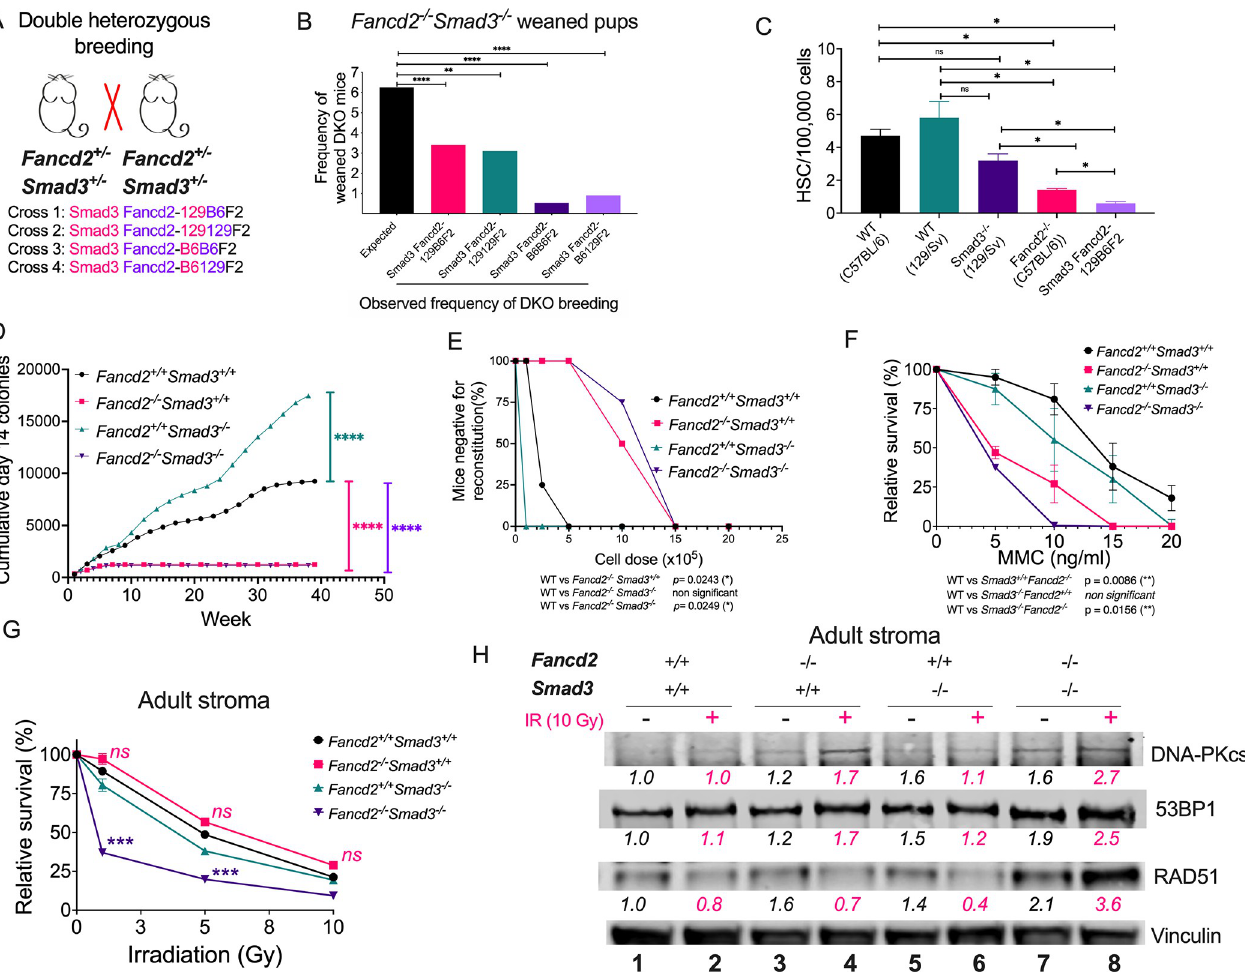
Fig 2. Smad3 loss is synthetic lethal with Fancd2 loss and surviving DKO mice do not have improved adult hematopoiesis. (A) Two different Smad3 +/- and Fancd2 +/- mouse strains on two different genetic backgrounds (129/Sv and C57BL/6) were bred to obtain 4 strains of Smad3 -/- Fancd2 -/- double Knockout (DKO) mice: Smad3 Fancd2-129B6F2; Smad3 Fancd2-129129F2; Smad3 Fancd2-B6B6F2 and Smad3 Fancd2-B6129F2 (See also S2A Fig). (B) Breeding frequency of DKO mice was significantly reduced in all 4 background combinations compared to the expected 6.5% frequency of DKO births from breeding double heterozygotes, suggesting embryonic lethality. For Smad3 Fancd2-129B6F2; Smad3 Fancd2-129129F2; Smad3 Fancd2-B6B6F2 and Smad3 Fancd2-B6129F2, we tested whether the frequency of births is significantly different from an expected frequency of 1 in 16, using the two-sided proportional test. The p-values are adjusted for multiple tests with the Bonferroni method. The adjusted p-values for the four breeds are < 0.0001, 0.0028, < 0.0001 and 0.0044 respectively, so the birth frequencies are all significantly smaller than 1/16 (i.e. 0.0625). The exact 95% confidence interval for the four breeds are respectively (0.0251, 0.0462), (0.0187, 0.0468), (0.0006, 0.0192) and (0.0011, 0.0325). (C) Reduced frequency of bone marrow hematopoietic stem cell (HSC) numbers in Smad3 Fancd2-129B6F2 mice compared to parental strains. (D) In vitro LTBMC assay showing that bone marrow from adult Smad3 Fancd2- 129B6F2 ( Fancd2 -/- Smad3 -/- ) mice have a reduced production of hematopoietic progenitors, similar to a Fancd2 -/- ( Fancd2 -/- Smad3 +/+ ) mouse bone marrow genotype. Results are presented as cumulative day 14 CFU-GEMM forming cells. (E) Competitive repopulation capacity of the bone marrow in transplant assays showing that hematopoietic cells derived from adult Smad3 Fancd2-129B6F2 ( Fancd2 -/- Smad3 -/- ) mice have a defective hematopoiesis, similar to Fancd2 -/- ( Fancd2 -/- Smad3 +/+ ) mice. (F) Survival of stromal cell lines derived from the bone marrow of adult mice showing that cells from Smad3 Fancd2- 129B6F2 ( Fancd2 -/- Smad3 -/- ) mice are hypersensitive to MMC. (G) Survival of stromal cell lines derived from bone marrow of adult mice showing that cells from Smad3 Fancd2-129B6F2 ( Fancd2 -/- Smad3 -/- ) mice are hypersensitive to irradiation. (H) Western blots of the lysates from stromal cell lines derived from bone marrow of adult mice showing that cells from Smad3 Fancd2-129B6F2 ( Fancd2 -/- Smad3 -/- ) mice overexpress the NHEJ proteins DNA-PKcs and 53BP1, and RAD51 a mediator for homologous recombination. A representative blot from three independent experiments is shown. Quantification relative to wild type in basal conditions and the loading control is shown below every lane. Pink indicates irradiated samples (10 Gy). Cell lysis for western blot was performed 4 h after IR. Data in (B) and (C) are represented as bar plots. Data in (D), (E), (F) and (G) are represented as mean ± SEM. p values of 0.01 to 0.05 were considered significant ( � ), p values of 0.001 to 0.01 were considered very significant ( �� ) and p values of < 0.001 were considered extremely significant ( ��� , ���� ). See also S2